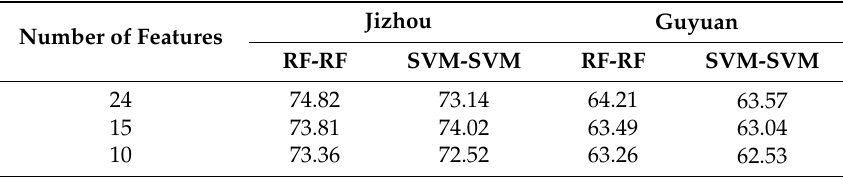
Table 10. The overall classification accuracy of RF and SVM using the features selected by the same classifier (RF-RF denotes the accuracy of the RF classifier using the features selected by RF; SVM-SVM denotes the accuracy of the SVM classifier using the features selected by